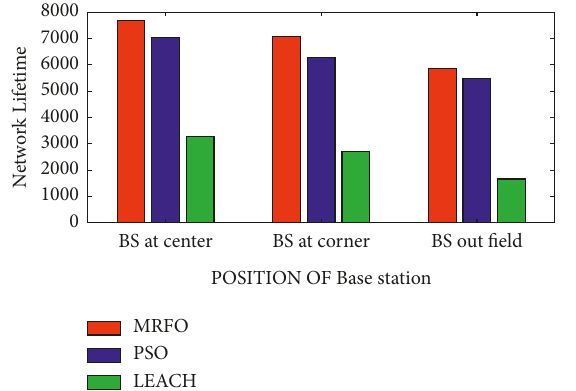
Figure 18: Number of rounds (lifetime) for 300-node network with 30 CHs.